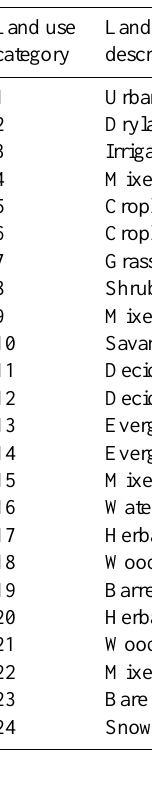
Table 4. USGS 24 land-use data categories.